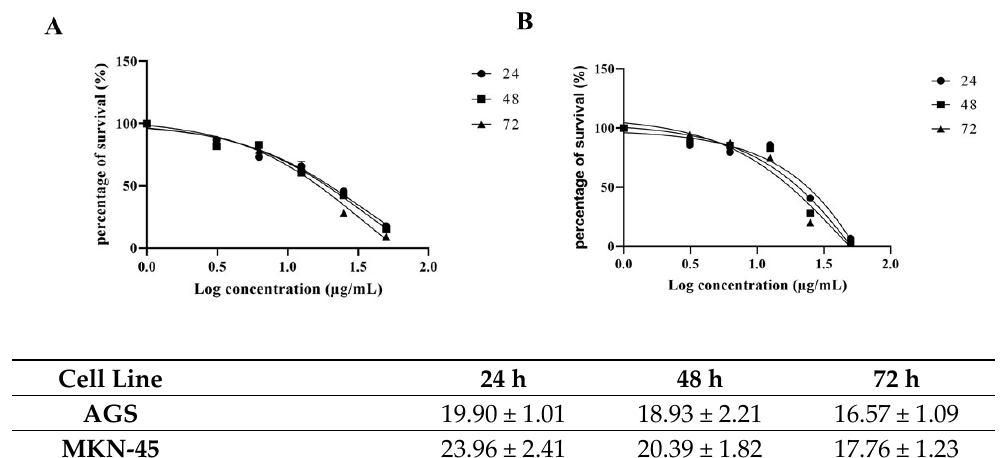
Figure 2. Effects of the carnosic acid on ( A ) AGS and ( B ) MKN-45 cells’ viability at three different incubation times (24, 48, and 72 h).